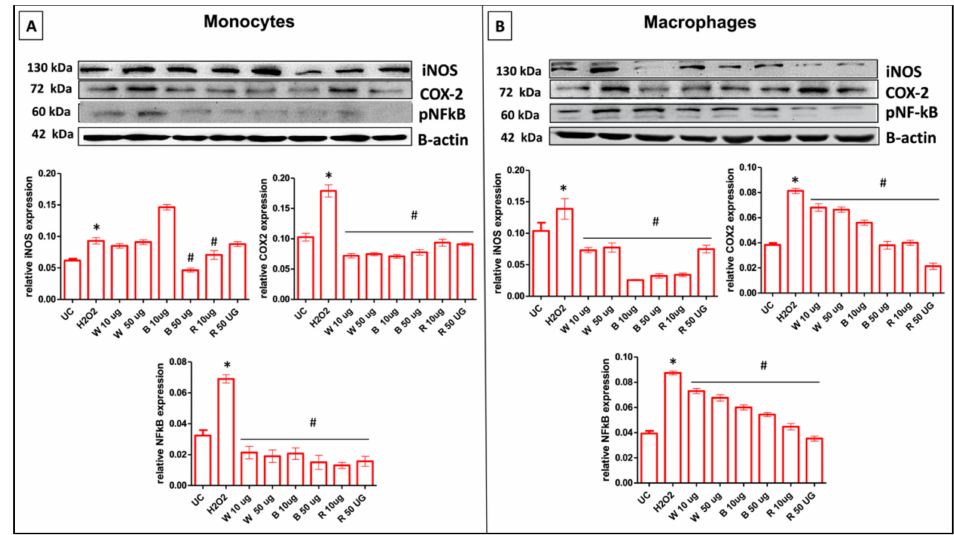
Figure 4. iNOS, COX-2, and NF-kB expression levels in undifferentiated (monocytes) and differenti- ated (macrophages) cells. Effect of different concentrations (10 and 50 µ g/mL) of garlic extracts, at 24 h of incubation, on the expression of iNOS, COX-2, and p-NF-kB protein in H 2 O 2 -stimulated cells. Representative image of Western blot experiments on undifferentiated (monocytes) cells ( A ) and differentiated cells (macrophages) ( B ) (top). At the bottom, averaged band density of iNOS, COX-2, and p-NF-kB normalized vs. β -actin. The data represented means ± SD ( n = 3). * p < 0.05 vs. UC; # p < 0.05 vs. H 2 O 2 -treated cells. UC: untreated control, W: white tunica, B: bulb, R: red